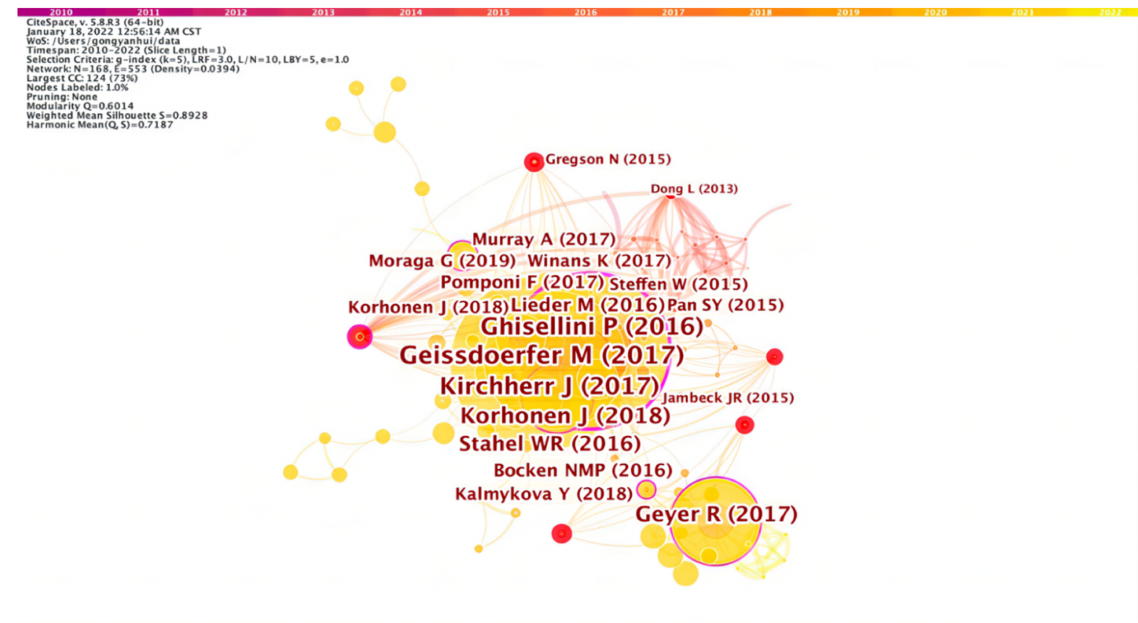
Figure 6. Co-citation literature map